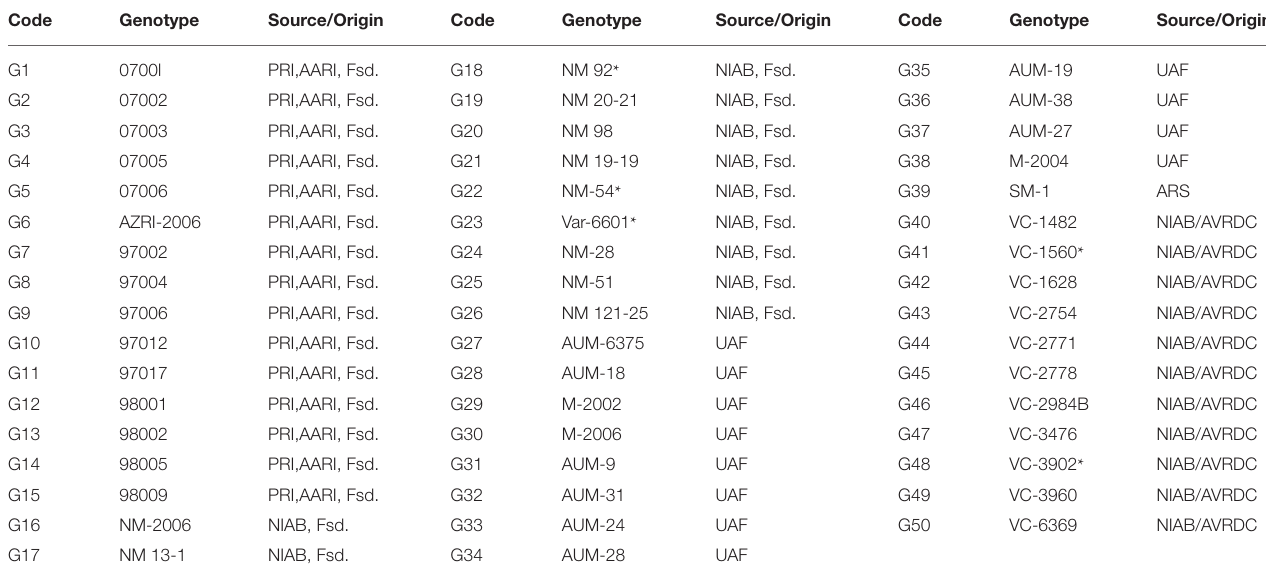
TABLE 1 | Mungbean [ Vigna radiata (L.) Wilczek] accessions